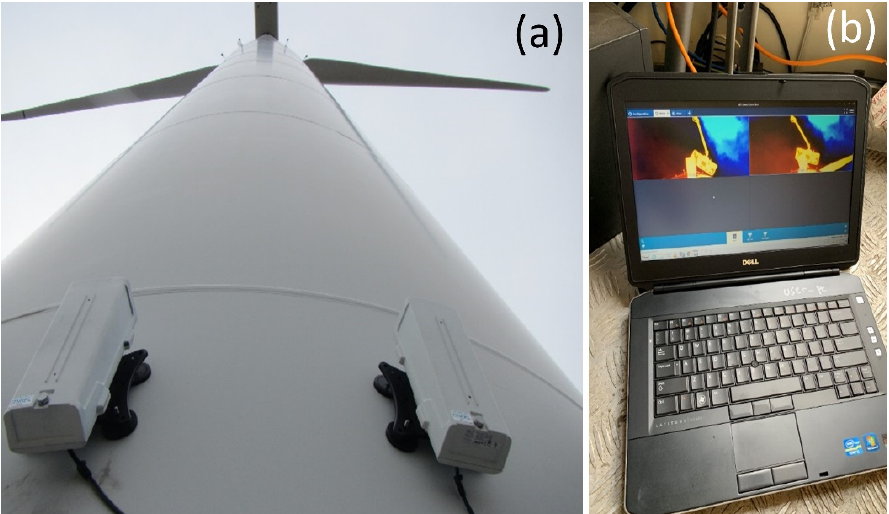
Figure 4. Bat, bird, and insect activity was monitored with pairs of time-synchronized thermal- imaging surveillance cameras mounted on the wind turbines ( a ). Imagery was automatically recorded to a laptop computer inside the base of the turbine ( b ) each night before being exported to a portable hard drive outside the turbine each day. Images by Paul